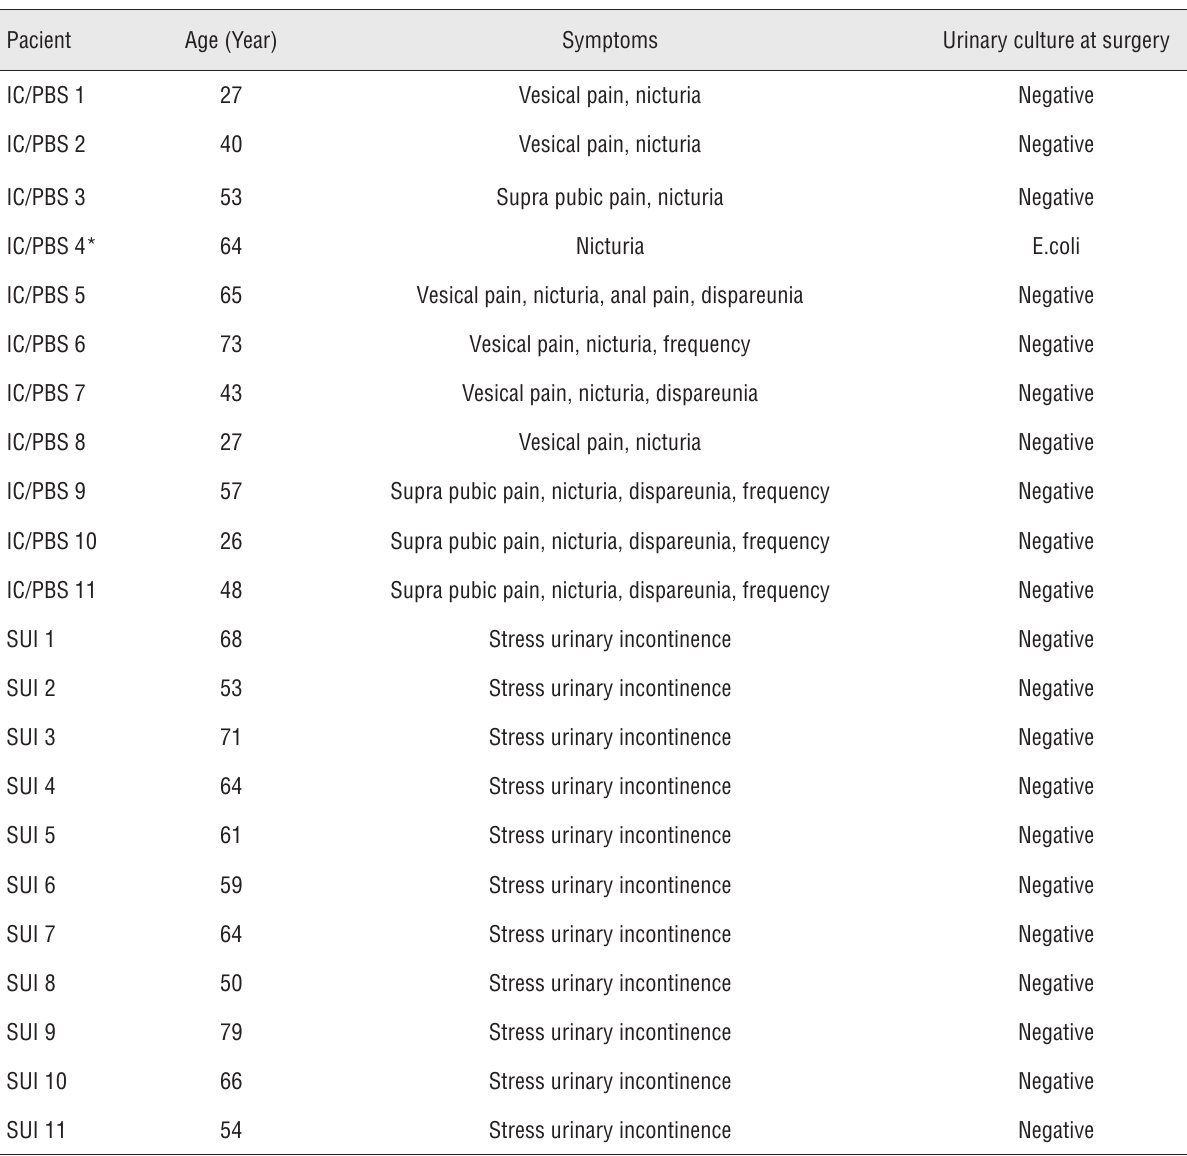
Table 1 - Demographics of IC/PBS and SUI